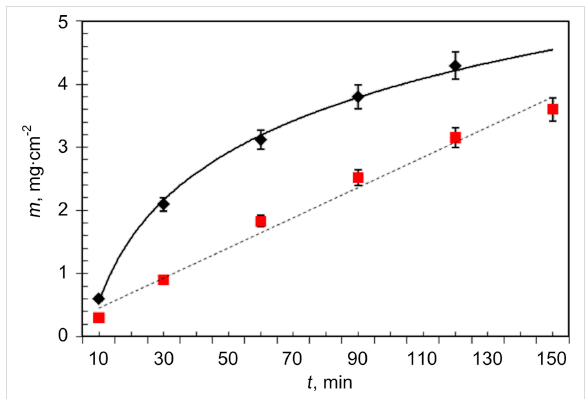
Figure 2: Deposited mass of Ni and of Ni–Fe as a function of the deposition time. Alumina thickness ( H PA ) is 45 μ m; pore diameter is 50 ± 5 nm. Black diamonds: Ni from solution no. 1; red squares: Ni–Fe from solution